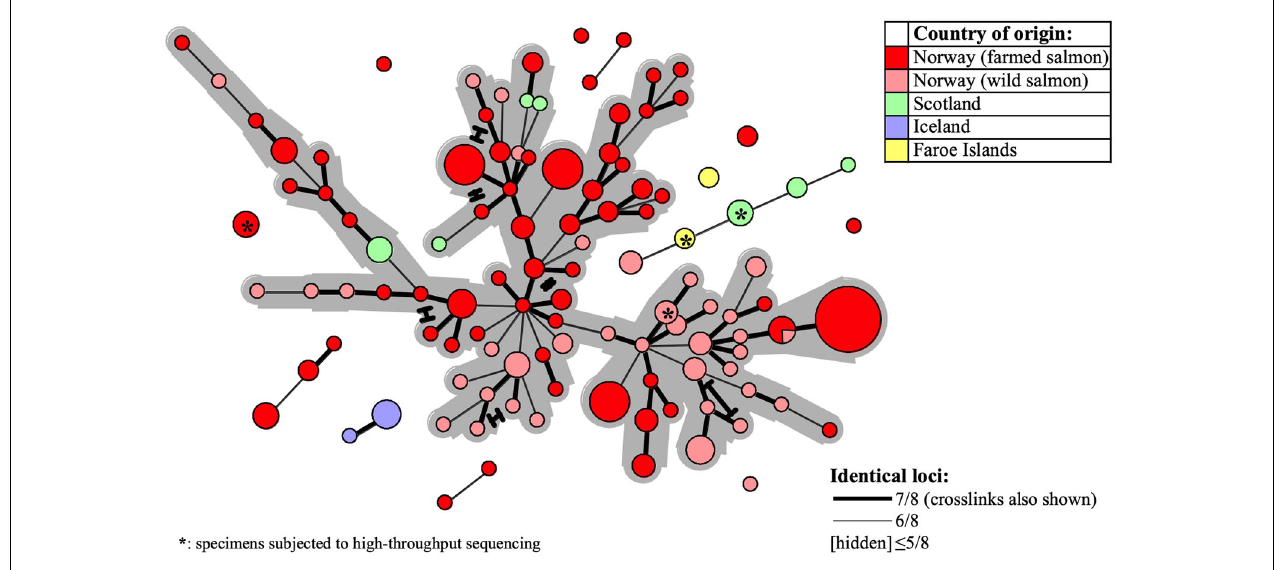
FIGURE 4 | Minimum-spanning-tree based on 227 SGPV MLVA profiles detected from 180 Atlantic salmon gill samples in Europe (see Table 1 and Supplementary Table S1 for further details). Coloring is with regard to fish type and/or country of origin (see upper right legend) and specimens herein subjected to Illumina sequencing are indicated with asterisks. Declining MLVA similarity is indicated by the declining thickness of branch connections (see lower right legend). Alternative branch connections (crosslinks) have terminal demarcations. The continuous network of interconnections produced between 186 out of the 227 profiles, within a threshold of ≥ 6/8 identical loci, has a gray